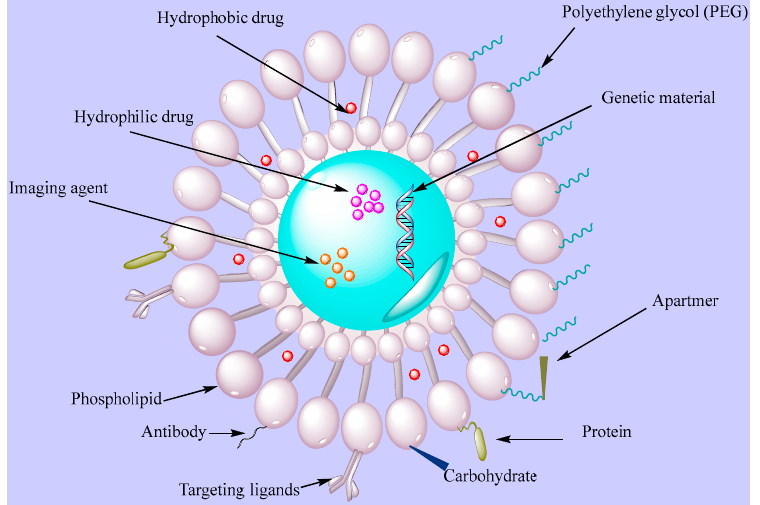
Figure 5. Functionalized liposomes with targeting ligands (PEG, antibodie, apartmers, proteins, carbohydrates).